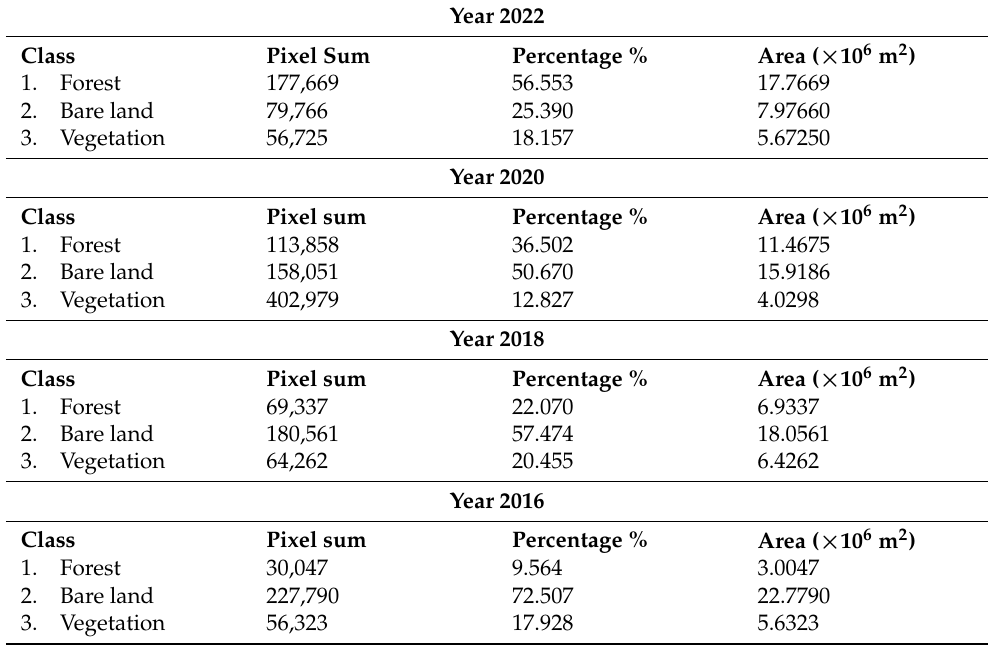
Table 6. Parameters of classified images.